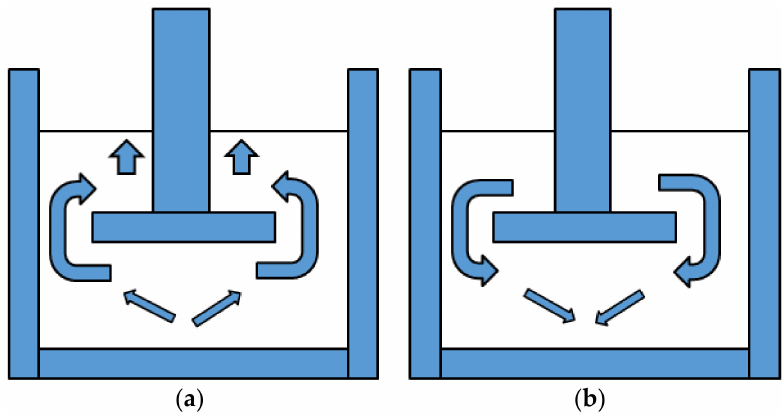
Figure 1. Movement of sample: ( a ) work of compression; ( b )